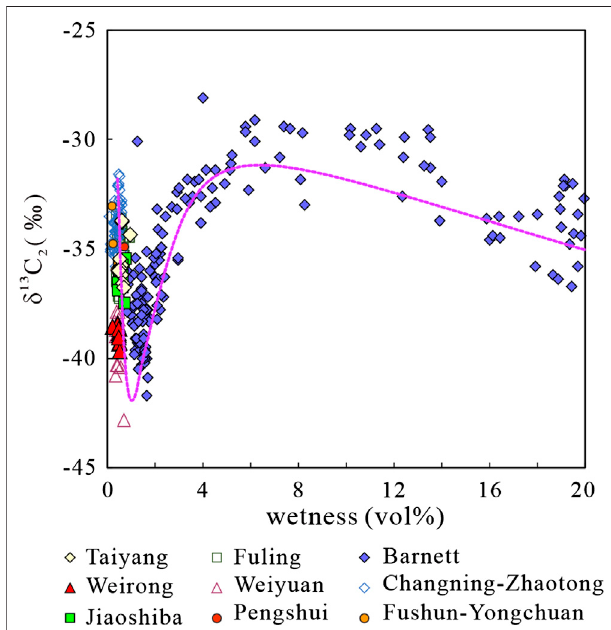
FIGURE 12 | Plot of wetness versus δ 13 C 2 of shale gases from Taiyang, Jiaoshiba, and Weirong gas fi elds. Also shown are shale gases from the published data (see text). The pink line was the calculated results by Xia and Gao (2018).